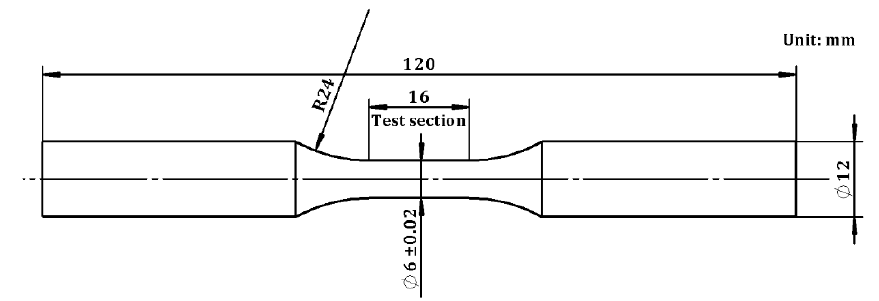
Figure 2. The low cycle fatigue (LCF) test specimen geometry.